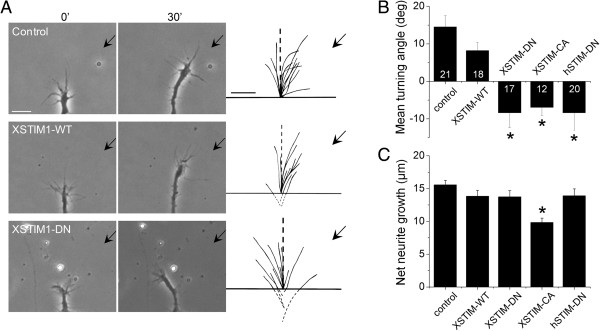
XSTIM1 is required for attractive turning responses of neuronal growth cones to a netrin-1 gradient. (A) Sample images of growth cone turning responses in a gradient of netrin-1 of a control Xenopus spinal neuron, and neurons derived from embryos injected with mRNA encoding wild-type (YFP-XSTIM1-WT), or dominant negative mutant (YFP-XSTIM1-DN). The left two columns of images show neuronal growth cones at the start (0 min) and the end of exposure (30 min) to a netrin-1 gradient (5 μg/ml in the pipette). The right column shows superimposed trajectories of neurite extension during the 30' period for a sample population of 12 neurons under the each condition. The origin is the center of the growth cone and the original direction of growth is vertical. Arrows indicate the direction of the gradient. Scale bars: 10 μm. (B) Summary of mean turning angles of growth cones in responses to a gradient of netrin-1 under different conditions. The number associated with the bar graph indicates the number of growth cones analyzed. Values represent mean ± s.e.m. (* indicates P < 0.01; Bootstrap-test). (C) Summary of net neurite growth during the 30 minutes turning assay under different conditions. Values represent mean ± s.e.m. (* indicates P < 0.05; Bootstrap-test).